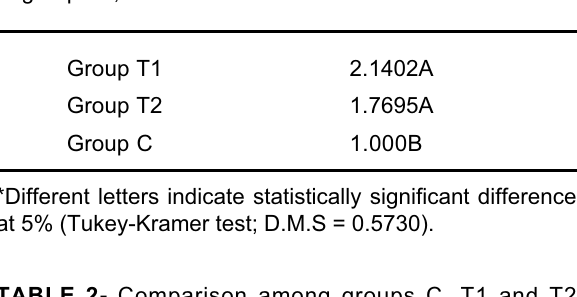
TABLE 2- Comparison among groups C, T1 and T2 regarding lip posture during evaluation of clinical